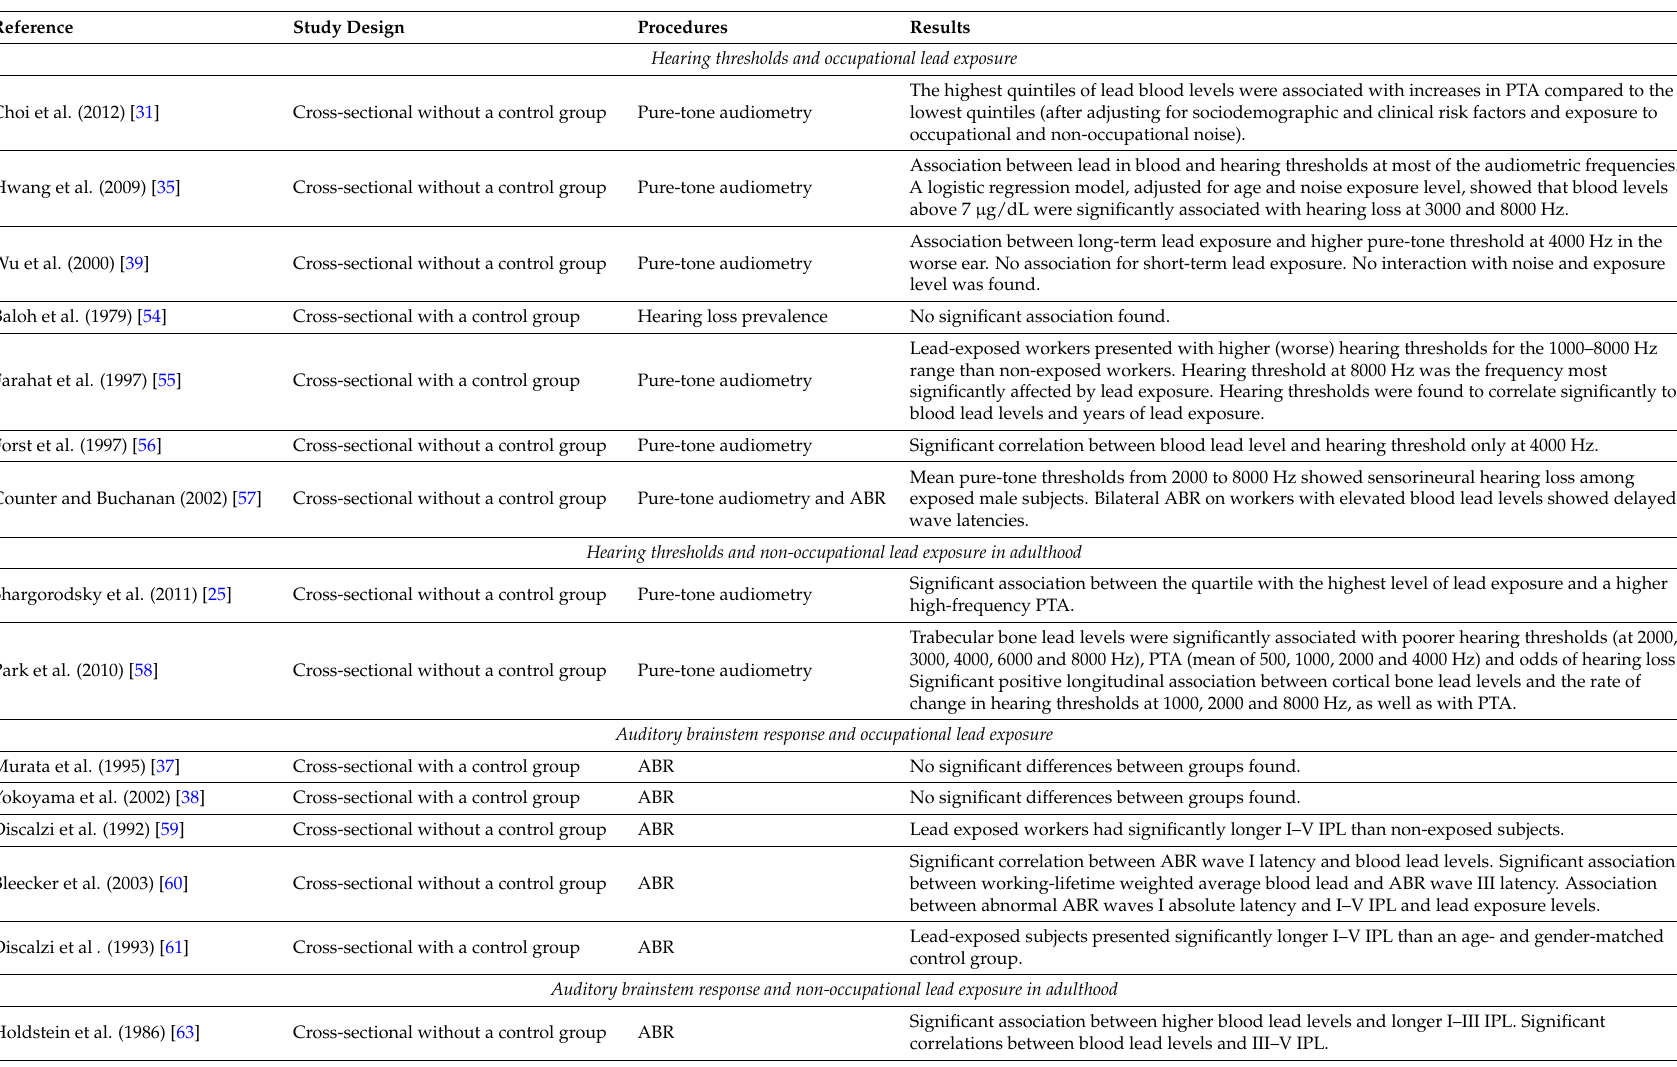
Table 2. Summary of studies investigating the effect of lead exposure in